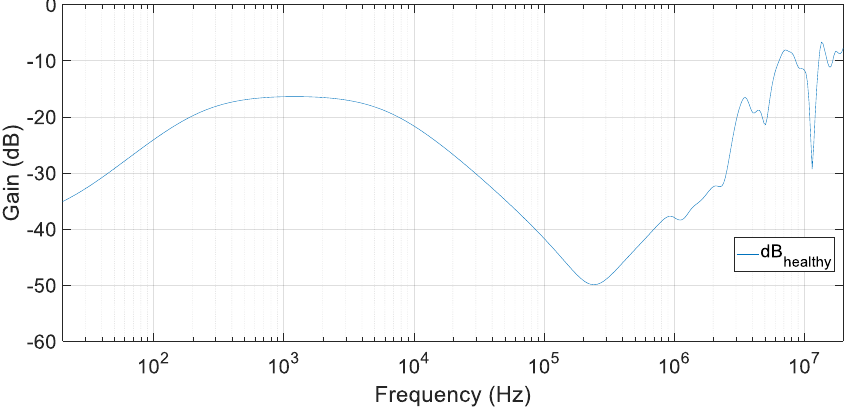
Figure 12. FRA test results with pure distillated water. Reference test.